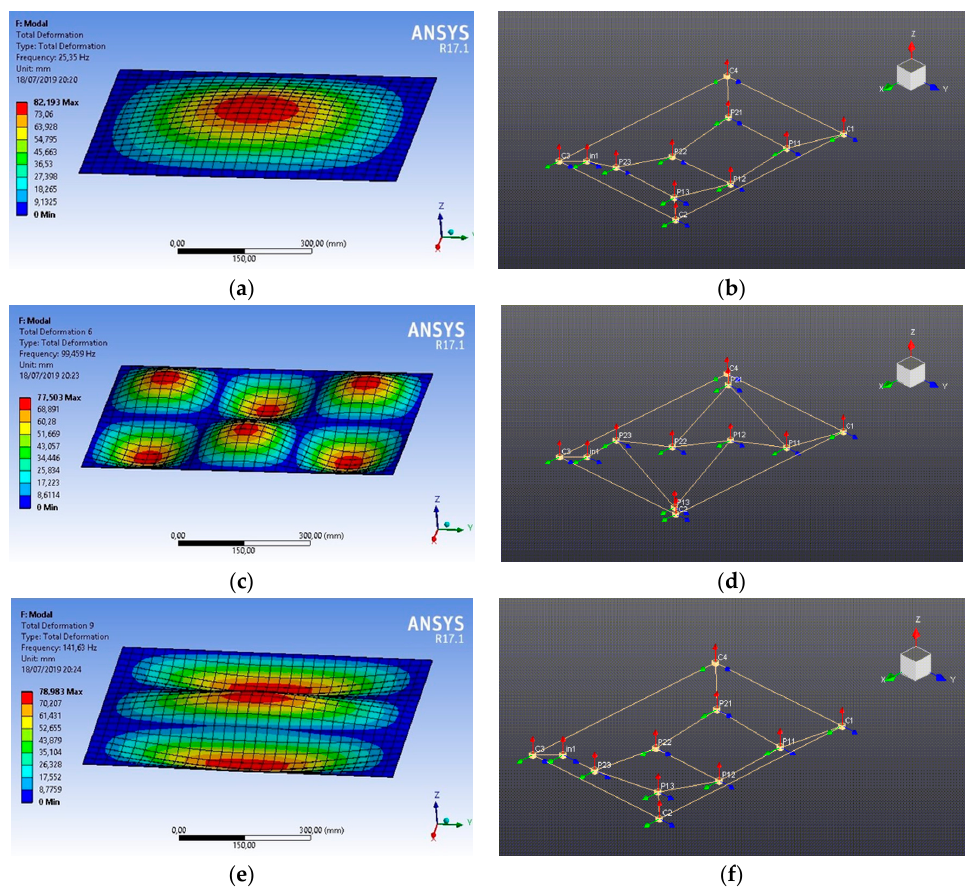
Figure 5. PN panel results, finite element model (FEM) vs. EMA vibration modes: ( a ) FEM #1; ( b ) EMA #1; ( c ) FEM #6; ( d ) EMA #6; ( e ) FEM #9; ( f ) EMA #9.